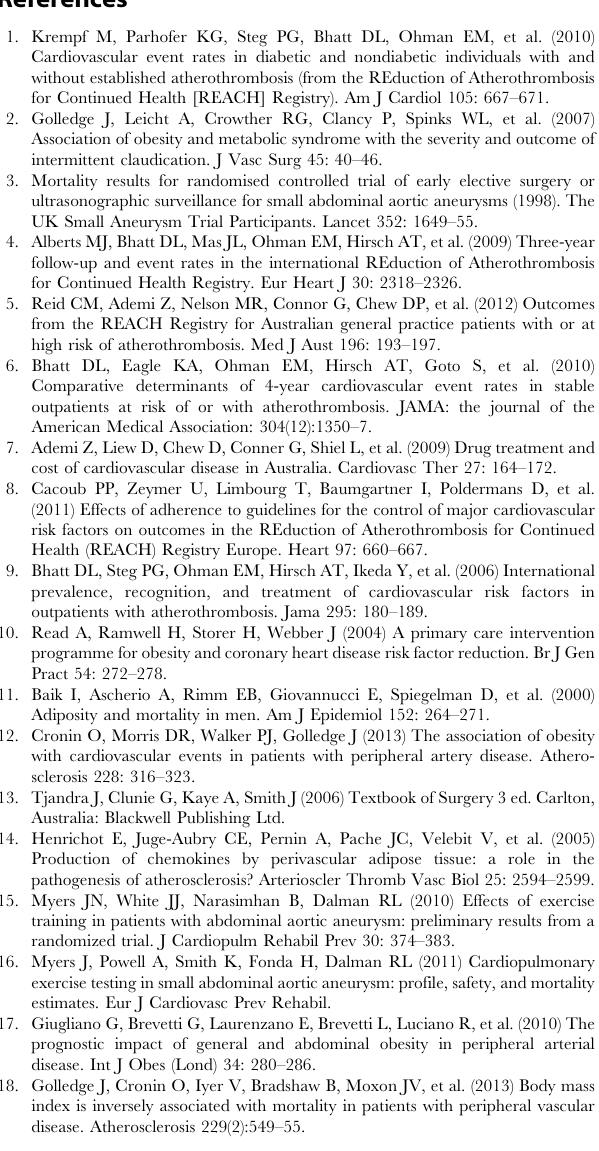
Table S4 Independent determinants of cardiovascular events (myocardial infarction, stroke, death) in patients with PAD without diabetes mellitus. Table S5 Independent determinants of cardiovascular events (myocardial infarction, stroke, death) in patients with AAA. Table S6 Independent determinants of cardiovascular events (myocardial infarction, stroke, death) in patients with PAD excluding AAA patients